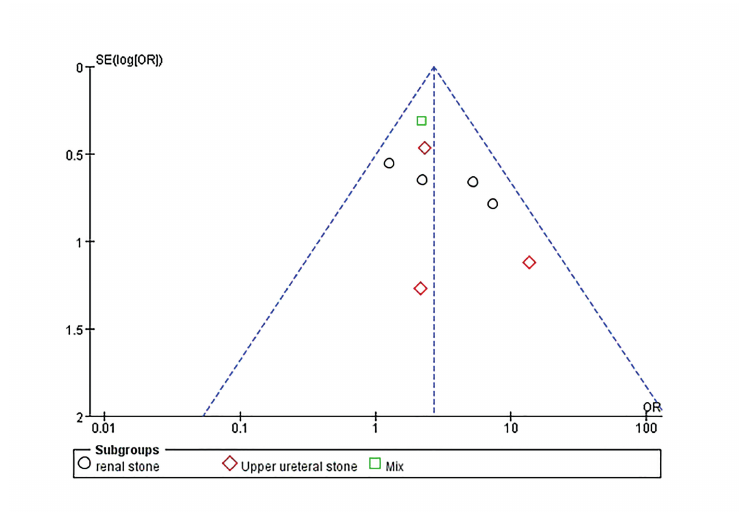
Supplementary Figure 4 - Funnel plot with stone clearance as the outcome according to the location of stone.